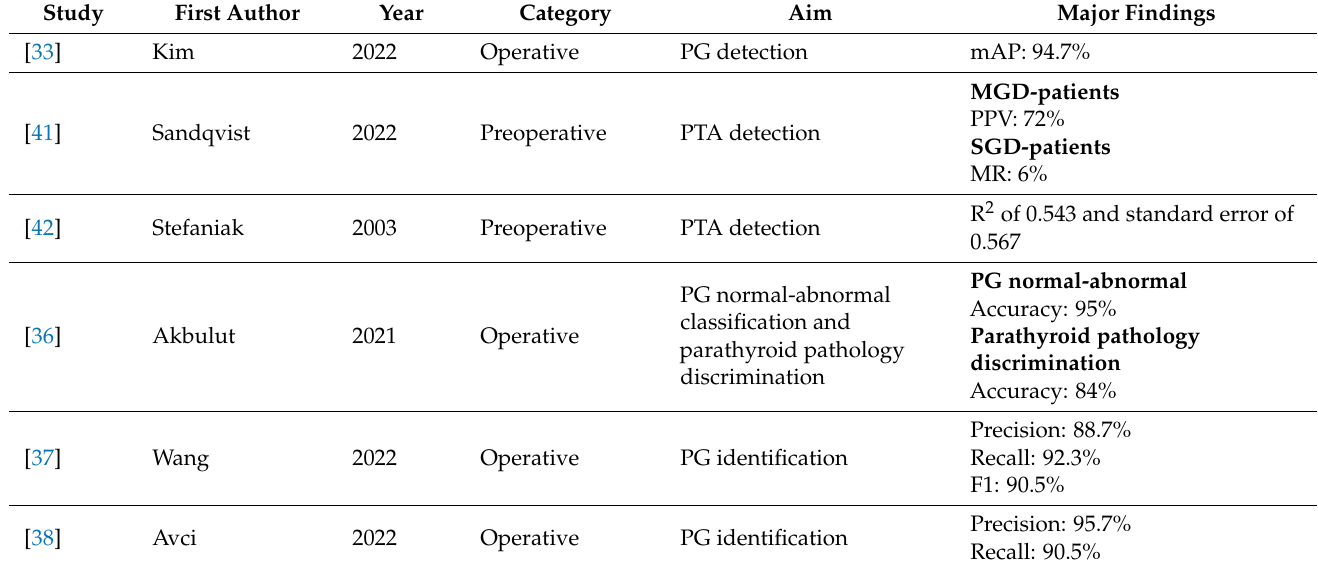
Table 1. Overview of the reviewed studies and their major outcomes. N.B.: PG: Parathyroid Gland, PTA: Parathyroid Adenoma, MGD: Multiglandular Disease, SGD: Single Gland Disease,